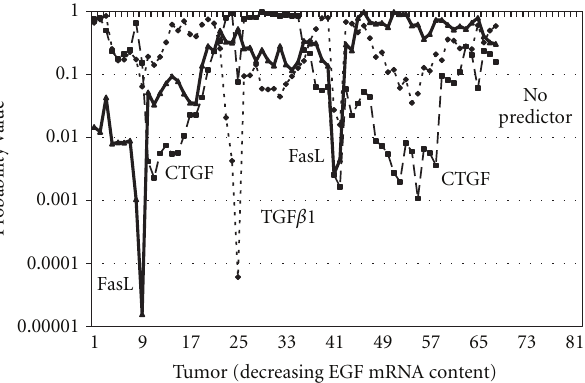
Figure 1: Probability indices for predictor variables FasL, TGF β 1, and CTGF regressed against Fas in 82 primary